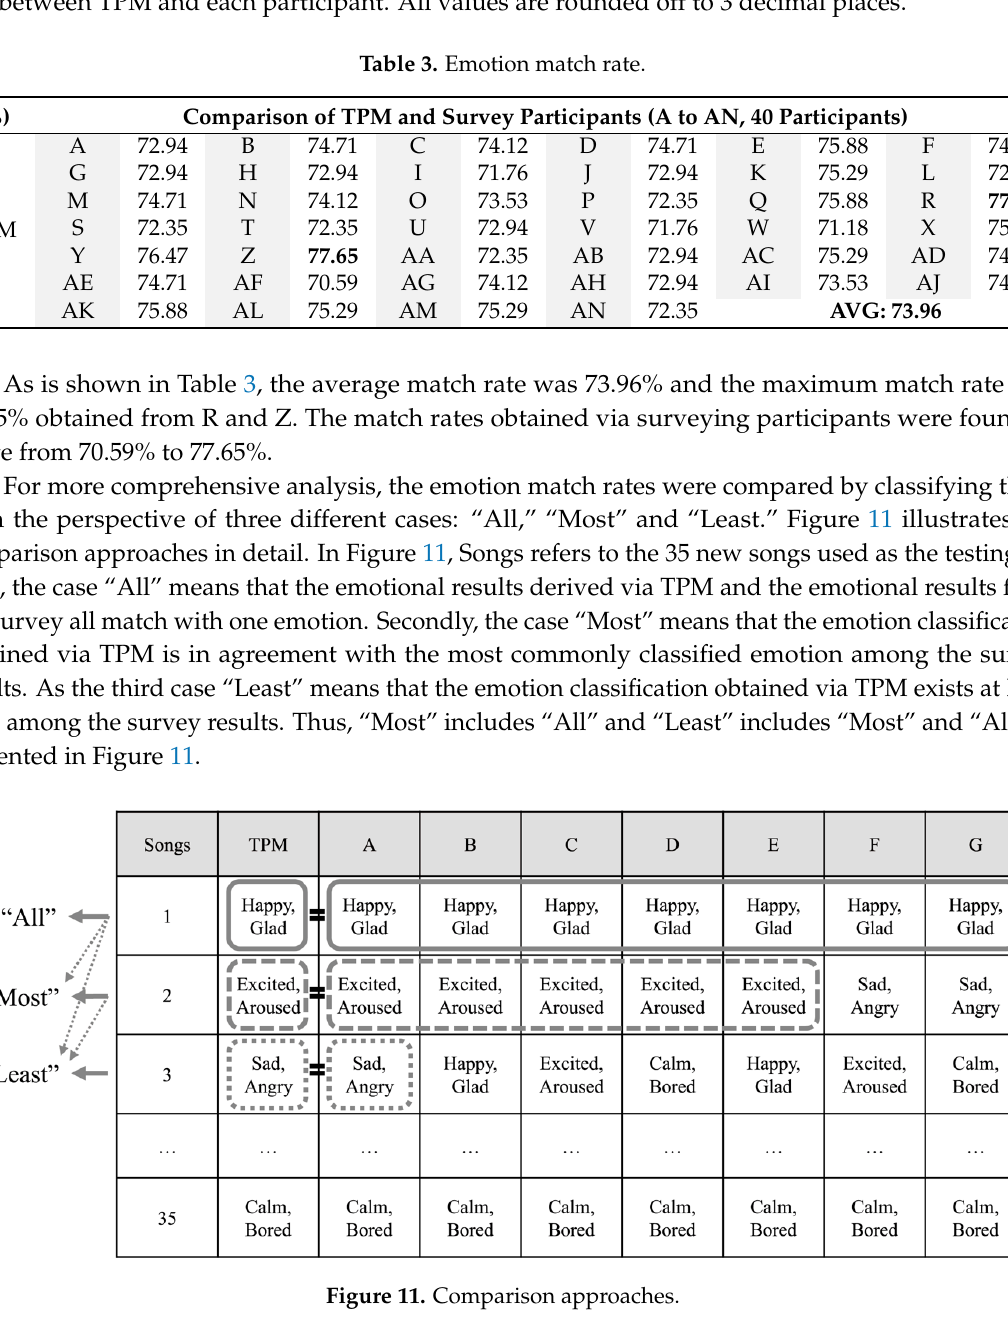
Table 4. Emotion match rates for the “All,” “Most” and “Least” cases. (%)